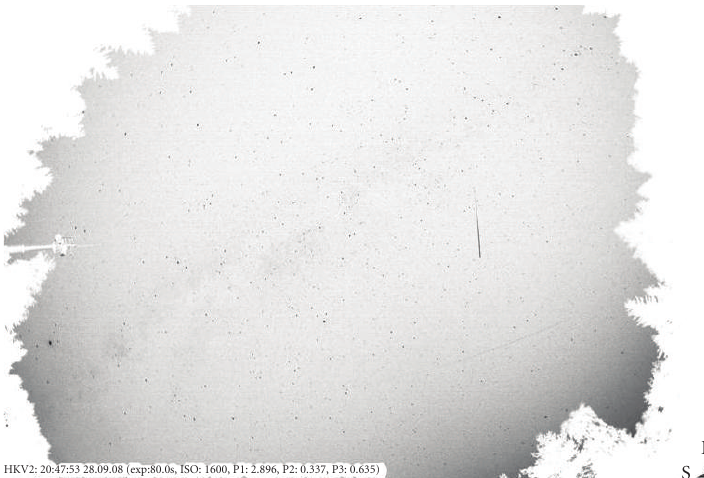
Figure 3: An example of raw nonguided image taken by the camera illustrated in Figure 1, exposure time 80 seconds (converted to